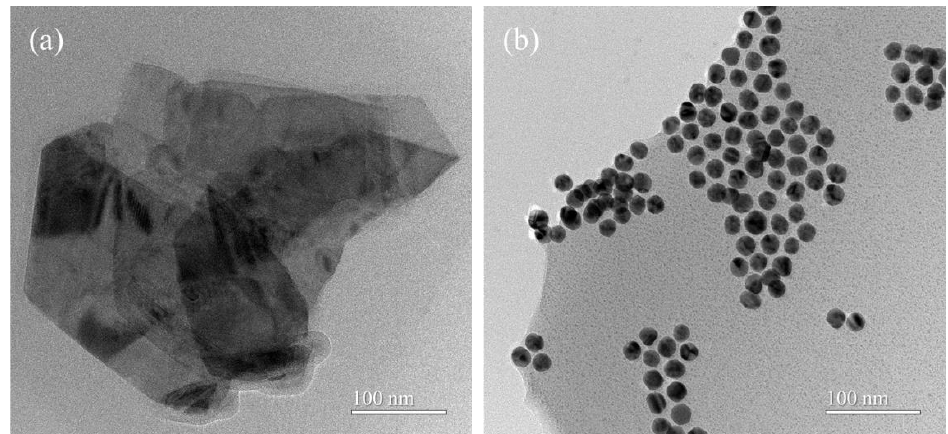
Figure 2. TEM images of ( a ) WS 2 , and ( b ) Ru-Au-WS 2 NCs. To investigate the properties of the synthesized Ru-Au-WS 2 NCs, the UV-vis absorp- tion spectra of the synthesized Ru-Au-WS 2 NCs, Au NPs, WS 2 sheets and pure Ru(bpy) 32+ were recorded. As shown in Figure 3, the UV-vis absorption peaks at 287 and 454 in the Ru(bpy) 32+ spectrum were attributed to the π–π* electronic transition of bi -pyridine and metal to ligand charge transfer adsorption, respectively. A typical absorption peak at 526 nm was assigned to the characteristic peak of Au NPs. Furthermore, WS 2 displays an obvious absorption peak at 633 nm, and three inconspicuous absorption peaks at 530 nm, 460 nm and 420 nm, respectively. Compared to the absorption spectra of Ru(bpy) 32+ (454 nm), Au NPs (526 nm) and WS 2 (633 nm), the characteristic absorption peak of Ru- Au-WS 2 NCs show different degrees of red-shift. All the above results demonstrate the successful preparation of Ru-Au-WS 2 NCs.